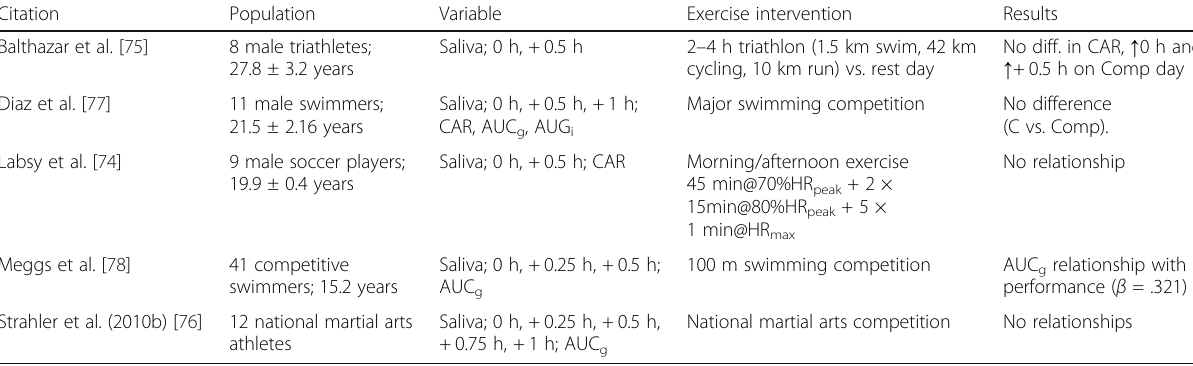
Table 5 CAR response to upcoming exercise stress ( n = 5)